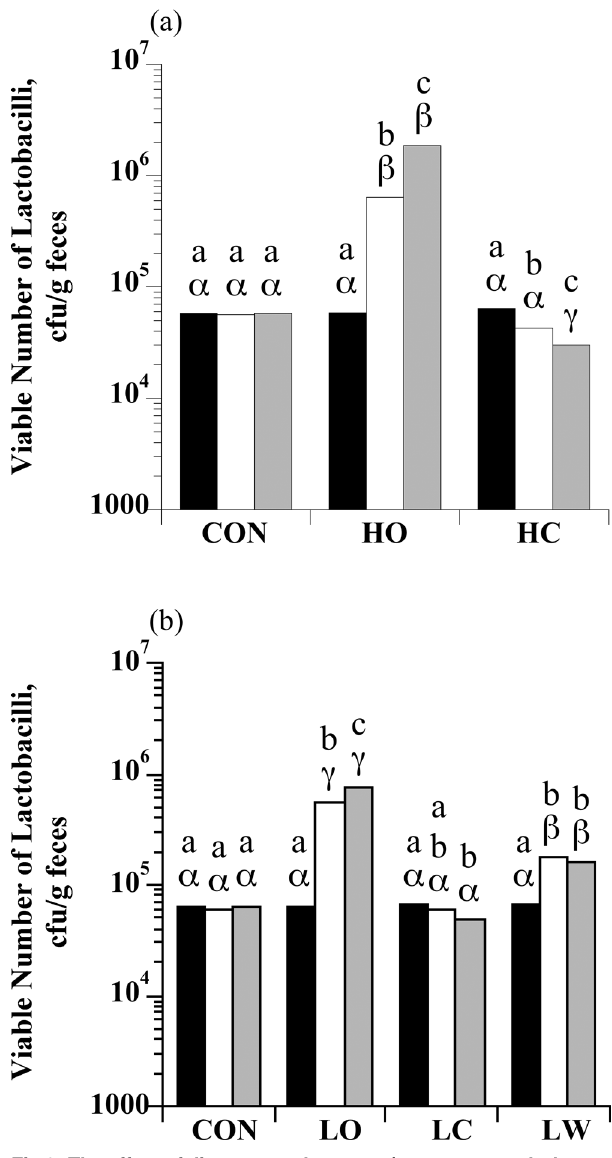
Fig 3. The effect of dietary starch source (corn, oats, and wheat middlings) on the viable number of lactobacilli in equine feces. (a) Horses were assigned to treatments: hay only (CON; n = 4), high oats (HO; n = 4; 2 g starch kg BW -1 ), or high corn (HC; n = 4; 2 g starch/kg BW). (b) Horses were assigned to treatments: hay only (CON; n = 5), low oats (LO; n = 5; 1 g starch/kg BW), low corn (LC; n = 5; 1 g starch/kg BW), or low wheat middlings (LW; n = 5; 1 g starch/kg BW). An initial sample was obtained at the end of the forage-only feeding period (S0; black bars) before starch sources were introduced. Additional samples were taken on d 6 when horses were receiving 50% of the assigned starch source (S1; open bars) and on d 13 when they were receiving 100% of the assigned starch source (S2; grey bars). Means lacking a common English letter are different within sample day ( P < 0.05). Means lacking a common Greek letter are different between sample days within a treatment ( P < 0.05); (a) Treatment: P < 0.0001, sample day: P < 0.0001, and treatment × sample day: P < 0.0001; Pooled SEM: treatment = 0.0481, sample day = 0.0315, and treatment × sample day = 0.0546 (log 10 transformed); (b) Treatment: P < 0.0001, sample day: P < 0.0001, and treatment × sample day: P < 0.0001; Pooled SEM: treatment = 0.0360, sample day = 0.0237, and treatment × sample day = 0.0473 (log 10 transformed).